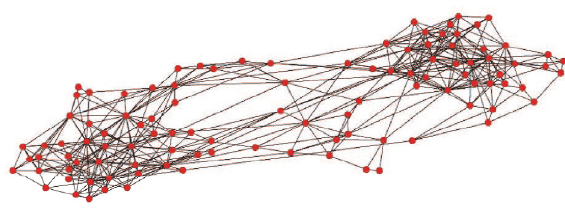
Figure 3: The graph of polbooks network.